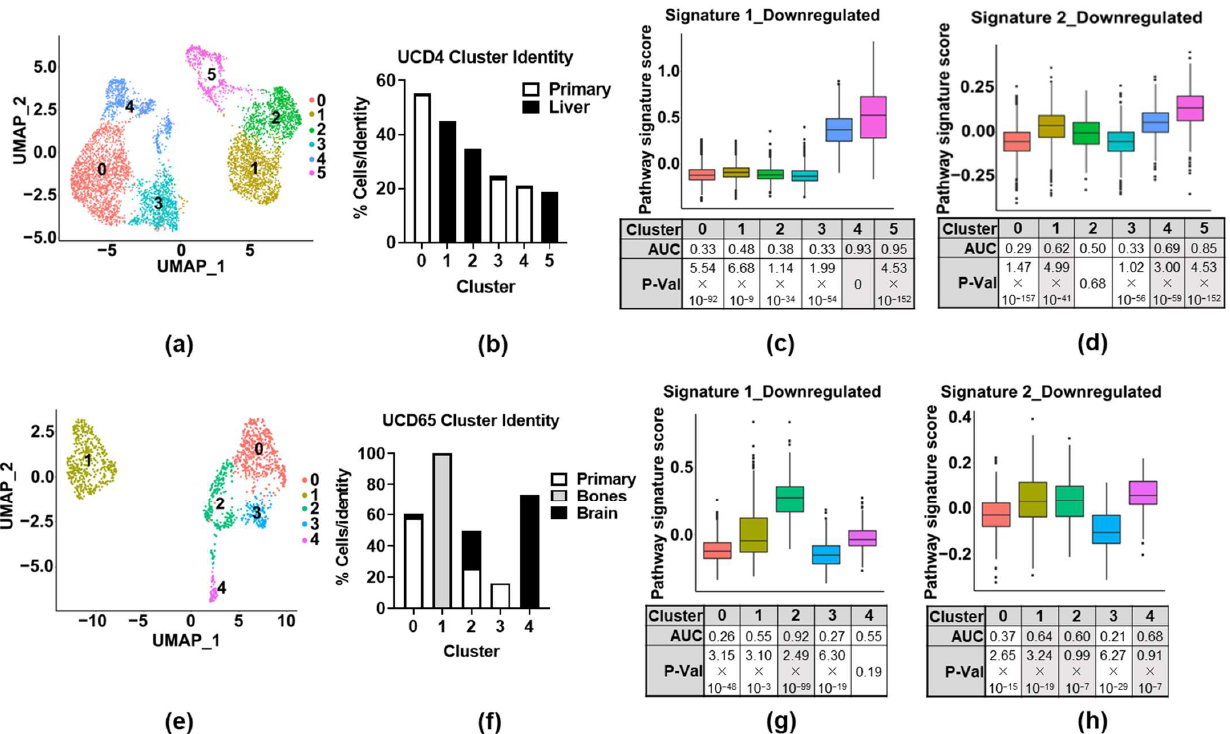
Figure 5. Invasive signatures are enriched in primary and metastatic PDX tumor cell populations. ( a , e ) UMAP plot showing bi-dimensional representation of single-cell transcriptomes of the PDX- derived breast cancer cell lines: ( a ) UCD4 and ( e ) UCD65, representing primary tumors and tumors in various sites of metastasis. ( b , f ) The contributions of each cell’s identity (i.e., primary or metastatic tumor) to each cluster (% of total number of cells in original identity) in each dataset. ( c , d ). Box plot and FEA for Signatures 1 and 2 in the UCD4 dataset. ( g , h ). Box plot and FEA for Signatures 1 and 2 in the UCD65 dataset.